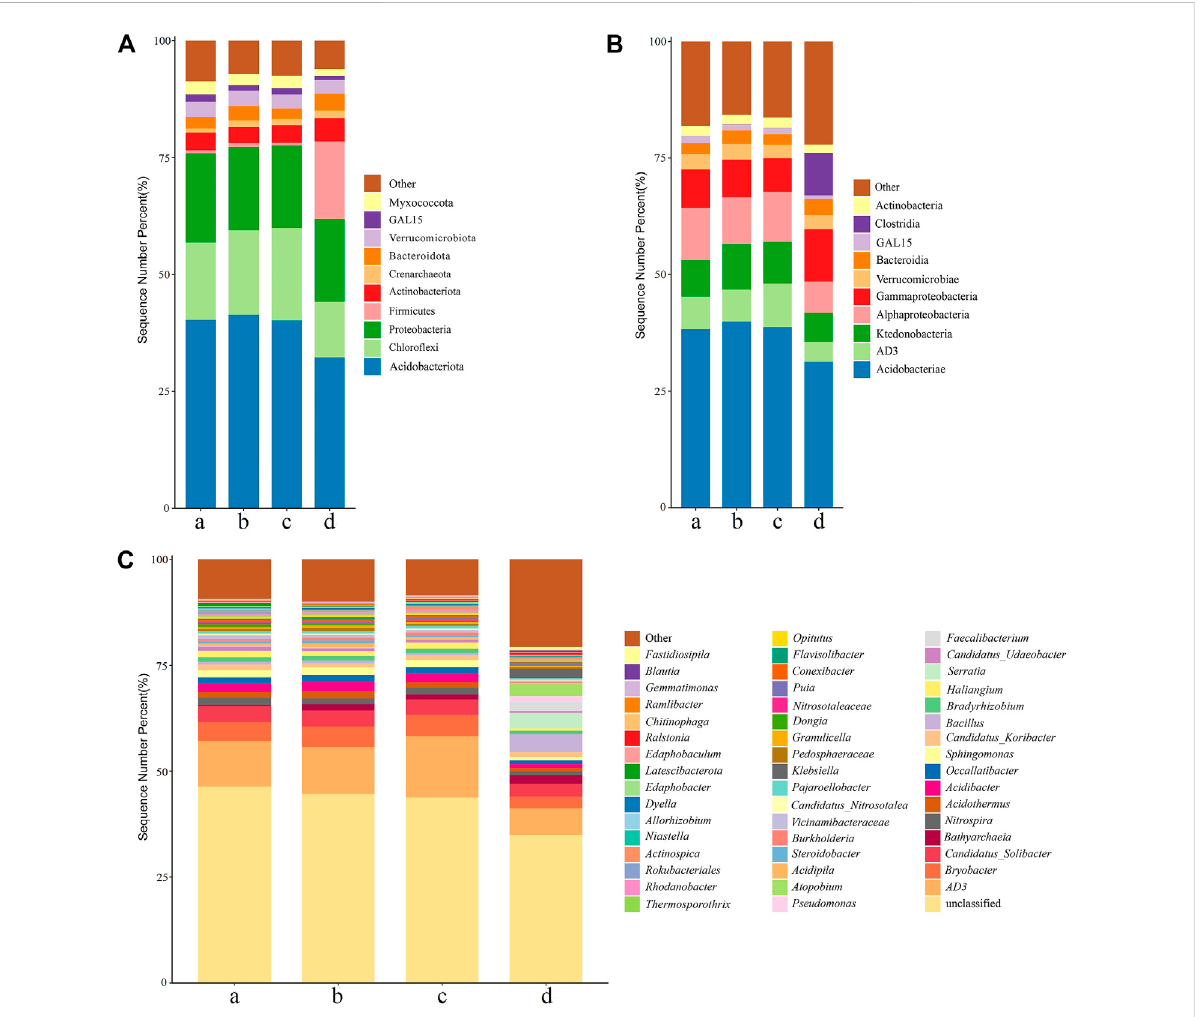
FIGURE 4 Soil bacterial community composition in different treatments at the phylum level. (A) Top 10 relatively abundant bacterial of the treatments at the class level (B) Top fi fty relatively abundant bacterial of the treatments at the genus level (C) . (A) litchi orchard with no intercropping; (B) litchi orchard intercropped with Desmodium ovalifolium ; (C) litchi orchard intercropped with Grona heterocarpos ; (D) litchi orchard intercropped with Stylosanthes guianensis